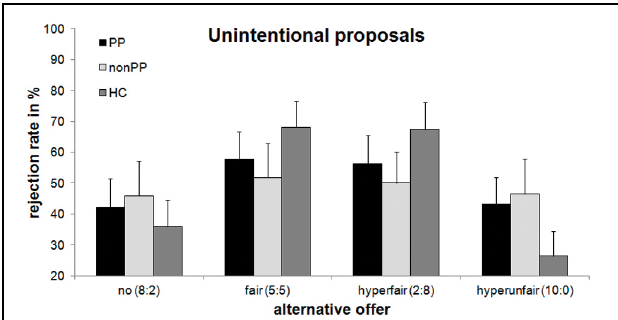
FIGURE 3 | Rejection rates of unintentional unfair offers with regard to alternative offers and group. Mean percentage and standard errors of rejection of 8:2-offers are displayed. PP, offenders with psychopathy; non-PP, offenders without psychopathy; HC, healthy controls.